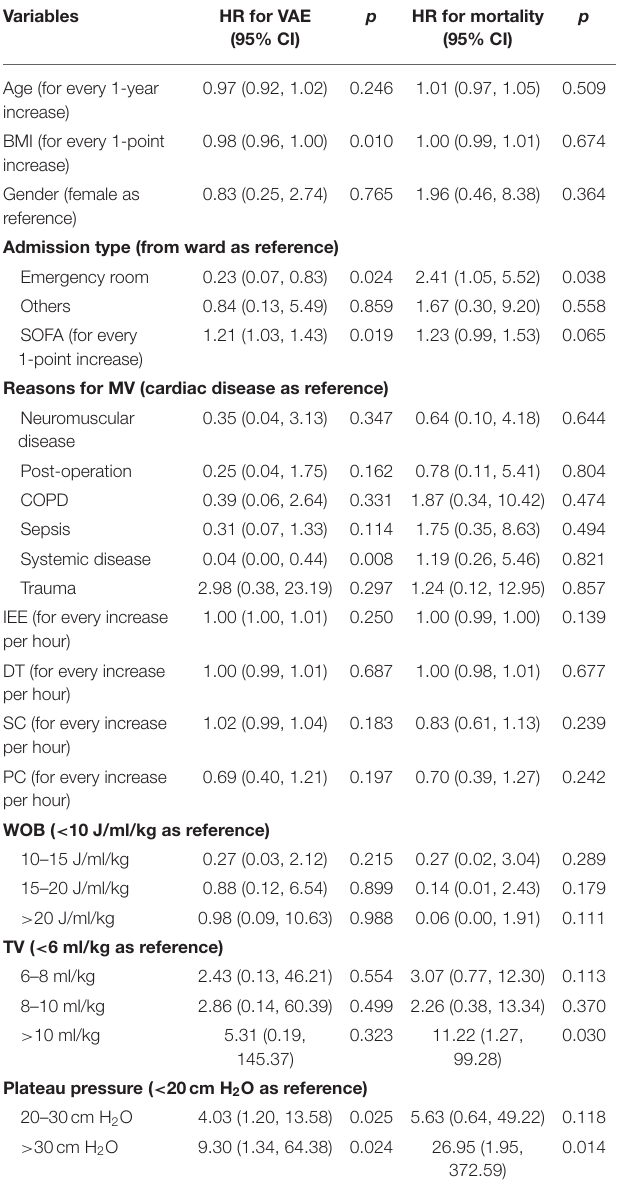
TABLE 5 | Cox regression model with time-varying